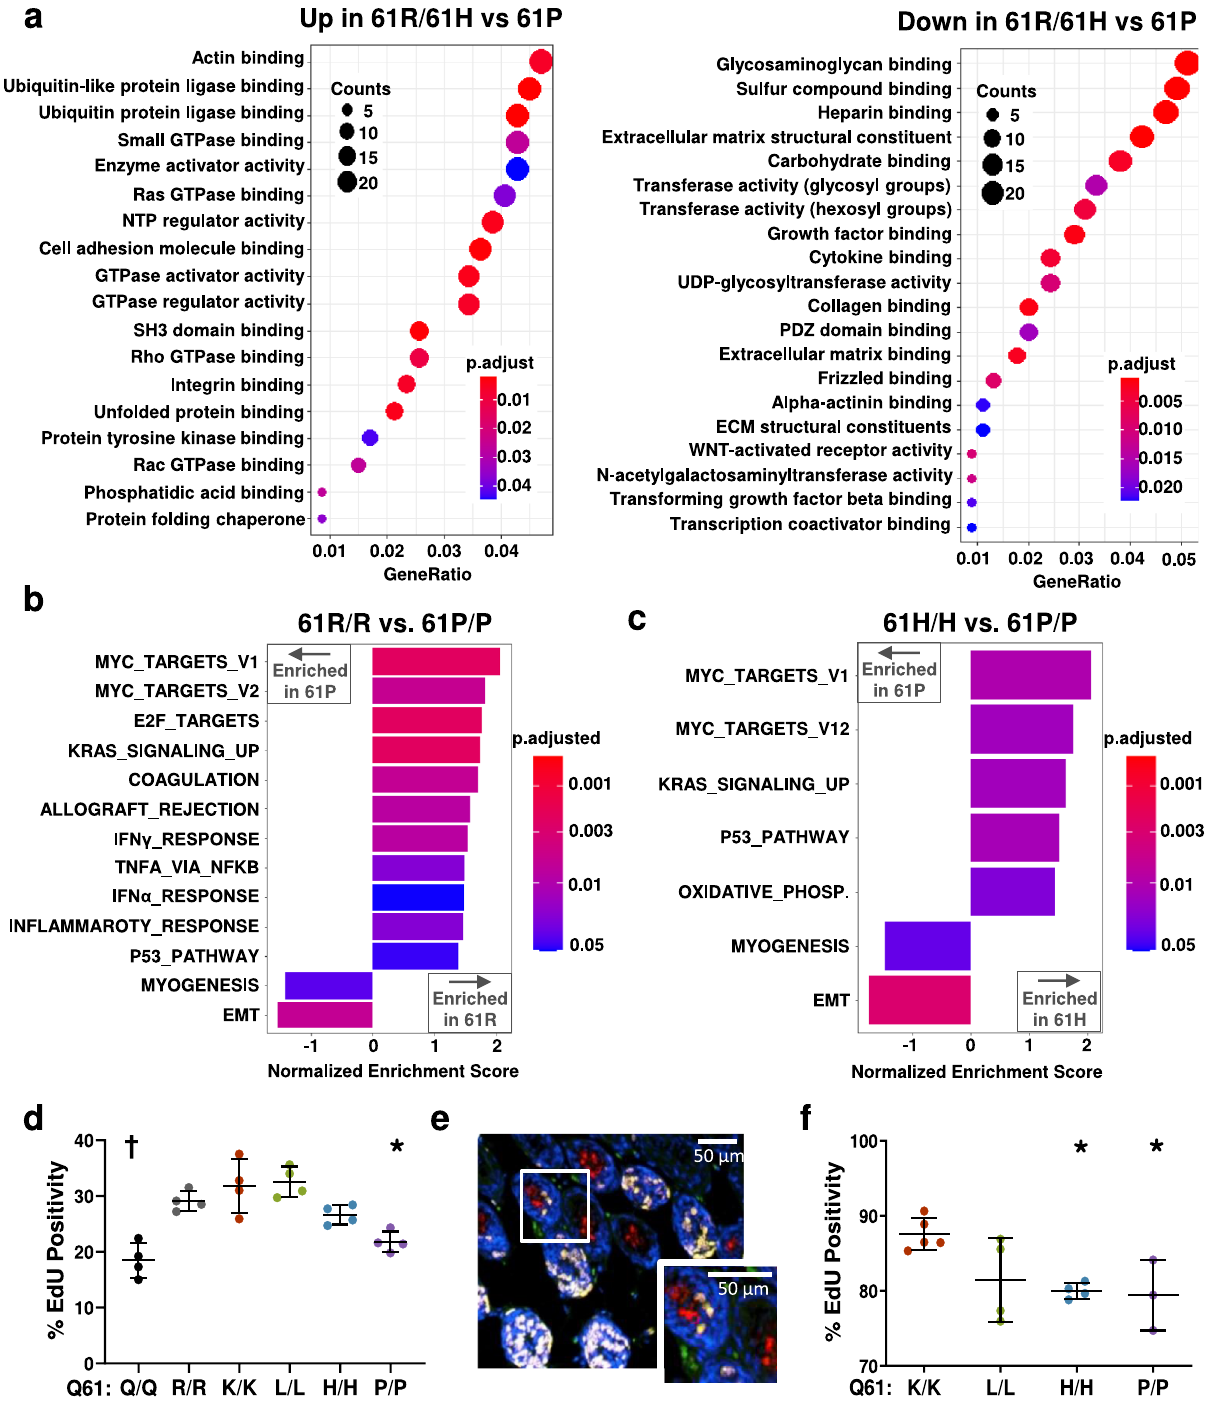
Fig. 3 Differential regulation of the RAS-Myc axis by melanomagenic and non-melanomagenic NRAS mutants. a Dot plots representing the molecular functions subset of Gene Ontology (GO) analysis of genes upregulated (left) or downregulated (right) in TN 61R/R and TN 61H/H MEFs compared to TN 61P/P MEFs. Three biological replicates per genotype were used for analyzed. Bar plot showing the differential enrichment of Hallmark gene sets ( p -adjusted < 0.05) in MEFs expressing NRAS 61R/R versus NRAS 61P/P ( b ) or NRAS 61H/H versus NRAS 61P/P ( c ). d Dot plot of fl ow cytometric analysis of EdU labeling in NRAS-mutant MEFs. n = 4 biologically independent MEF lines per genotype were examined over 4 independent experiments. e Representative image of EdU (proliferation, green) and gp100 (melanocyte, red) co-staining in skin harvested from a ten-day old mouse. n = 4 biologically independent mice were examined per genotype. f Dot plot of percent EdU positivity in melanocytes from 10-day old TN 61X/X mouse skin. The following number biologically independent animals were evaluated per genotype (K/K = 5, L/L = 4, H/H = 4, P/P = 3). Dot plot data are presented as mean values + / − SD where each dot represents one biological replicate. One-way ANOVA with a Tukey ’ s post-test was used to compare data between each genotype. NRAS mutant samples statistically different from NRAS 61R/R samples are indicated in the fi gure. Adjusted p -values for all comparisons can be found in Supplementary Table 2. * p < 0.05, † p < 0.001. Source data are provided as a Source Data fi